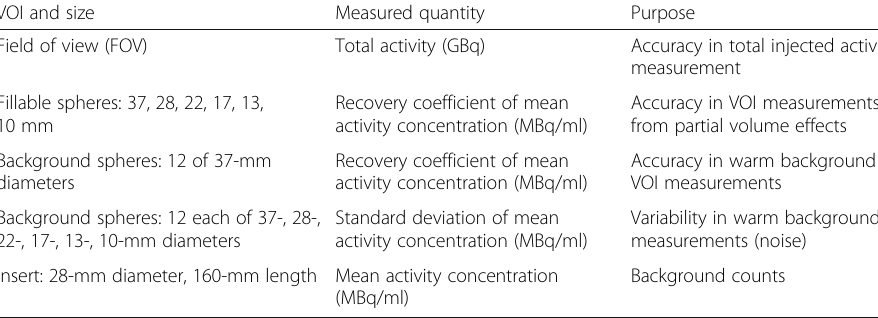
Recovery coefficient of mean activity concentration (MBq/ml) Standard deviation of mean activity concentration (MBq/ml)